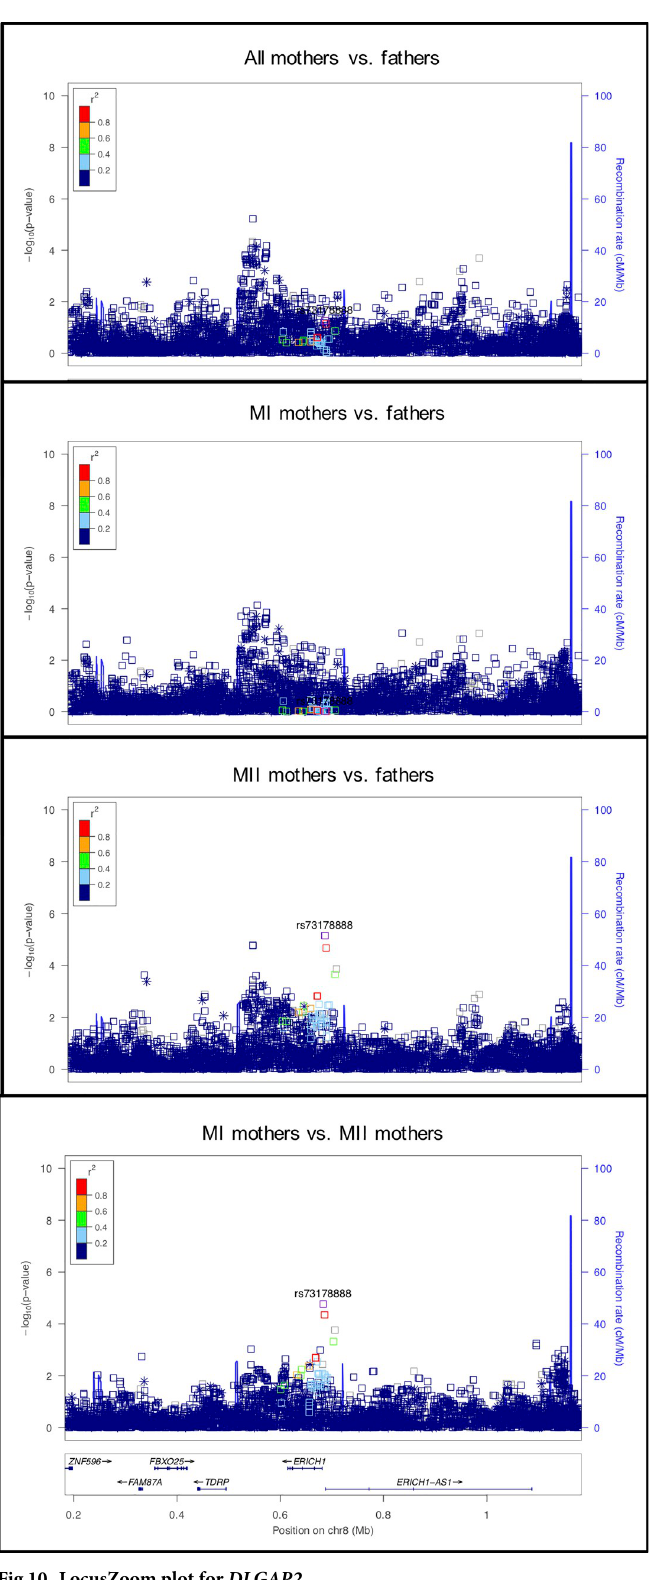
Fig 10. LocusZoom plot for DLGAP2